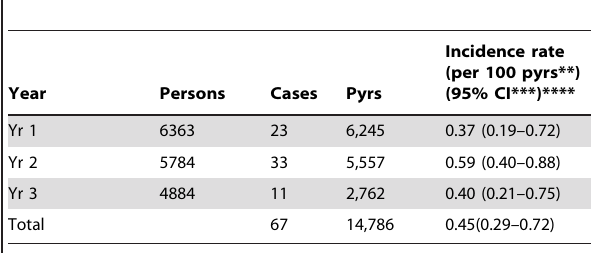
Table 4. Annual incidence rate by year of study up to February 2009 for bacteriologically confirmed TB* (n= 6,363).